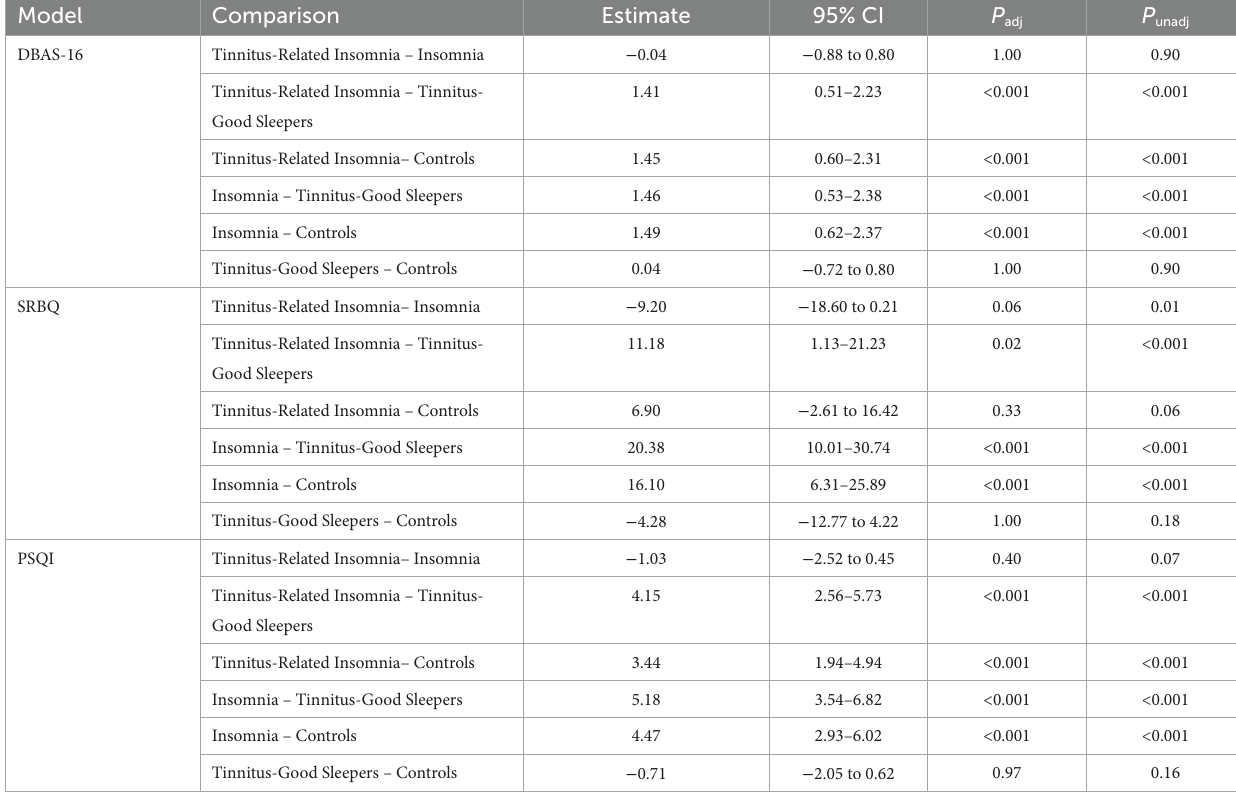
TABLE 4 Effect estimates, adjusted 95% confidence intervals, and adjusted and unadjusted p -values. Model Comparison Estimate